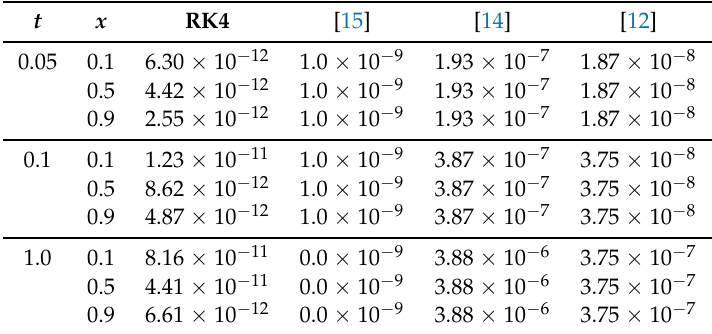
Table 3. Comparisons between the results obtained by the LMM with those adapted from [12,14,15] in term of L abs error norm for Test Problem 3.